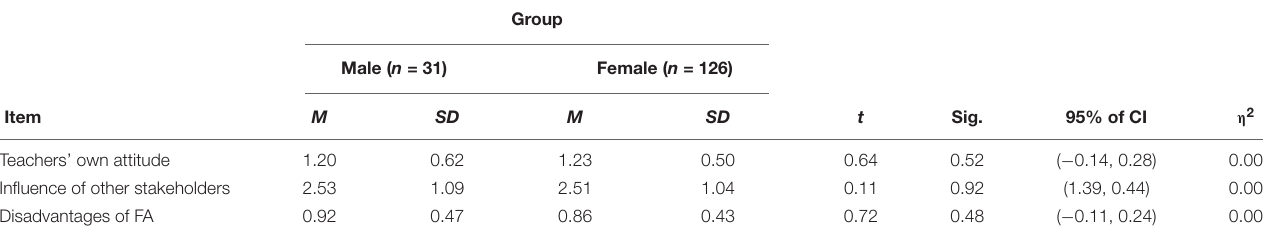
TABLE 4 | Independent-sample t -test of gender ( N = 157).